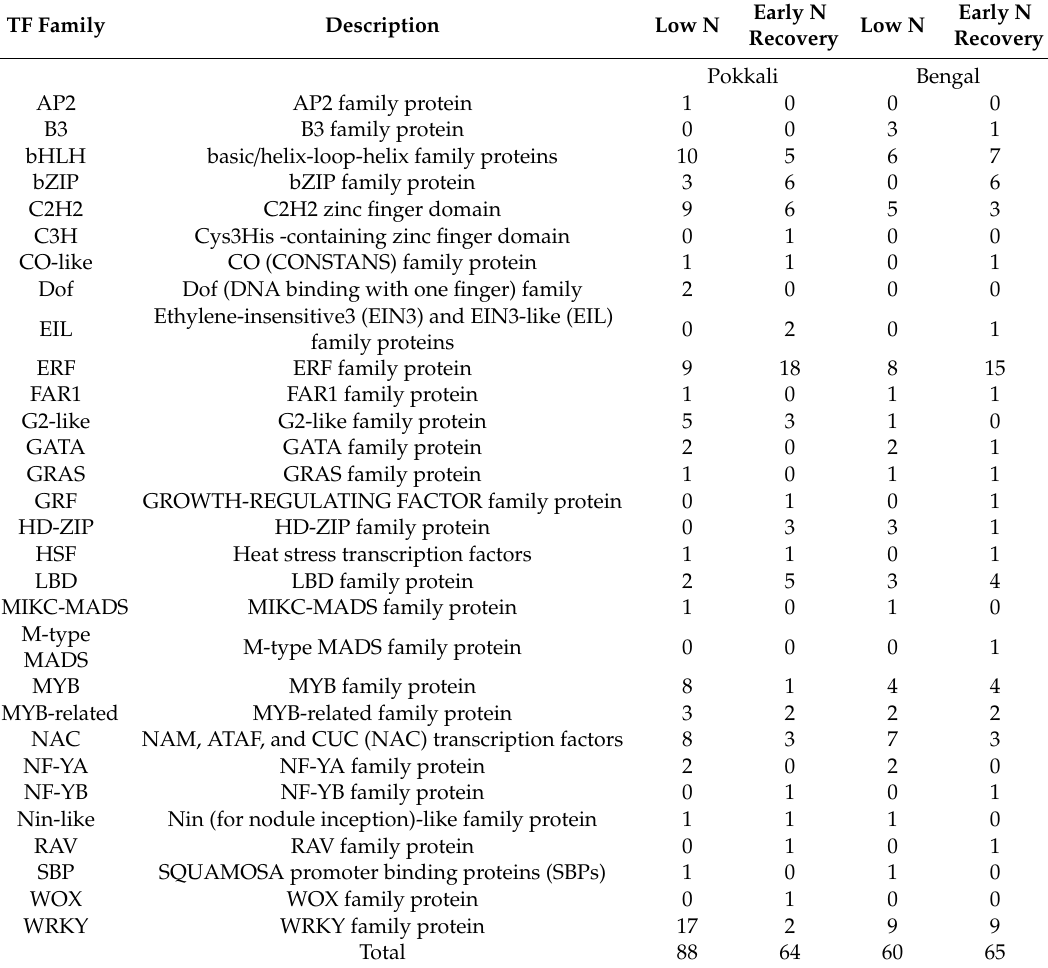
Table 4. Numbers of transcription factors (TFs) di ff erentially expressed in Pokkali and Bengal under low N and early (1-h) recovery